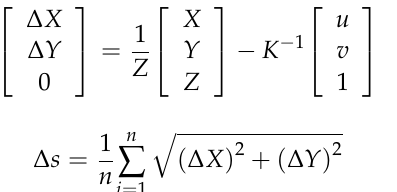
Table 3. Calibration results of RS-LIDAR-16 and MER-132-43GC-P.